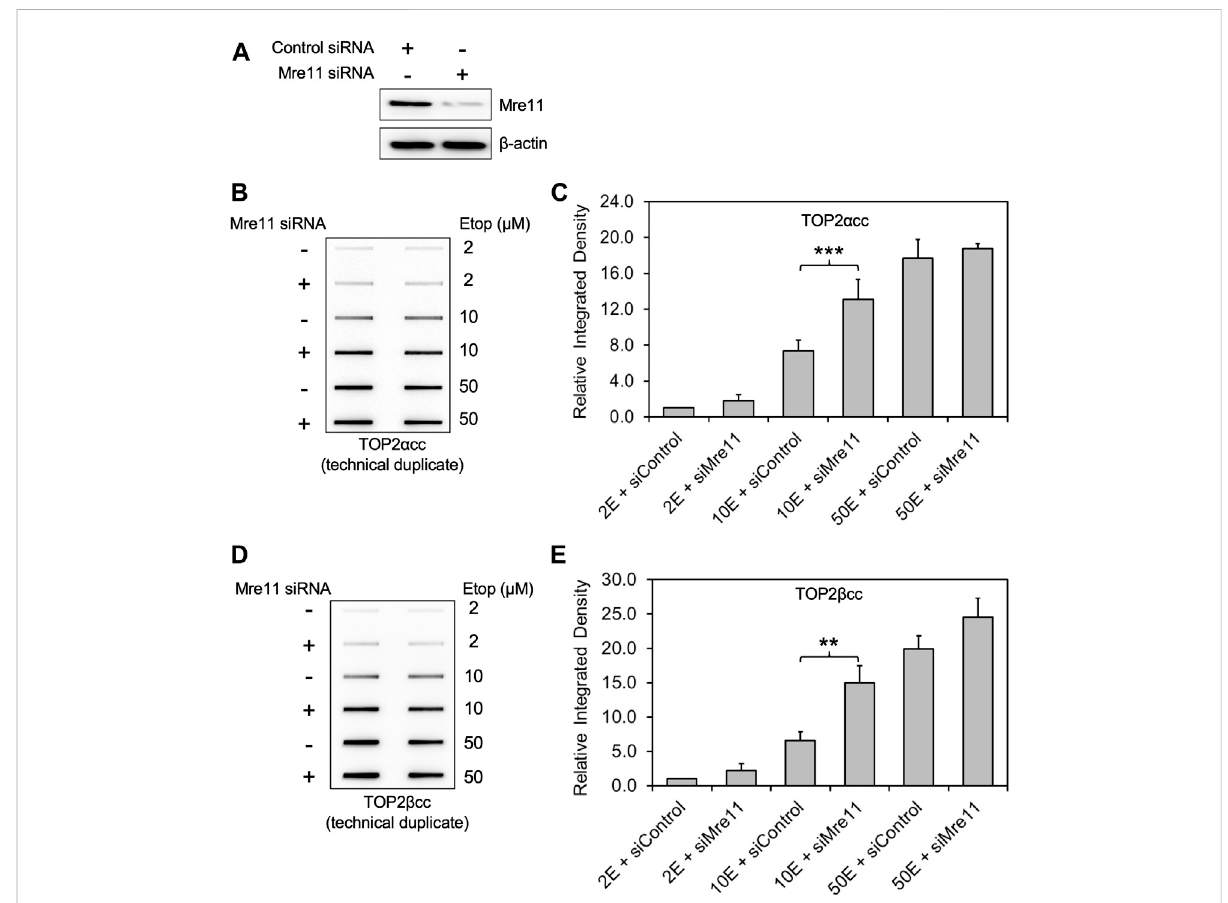
FIGURE 1 Knockdown of MRE11 by siRNA increases the level of etoposide-induced TOP2-DNA complexes as detected by ICE. RH30 cells were transfected with non-targeting siRNA control (siControl) or siRNA targeting MRE11 (siMRE11), followed by treatment with etoposide (Etop) at the indicated concentrations. (A) Western blot assessing MRE11 knockdown ef fi ciency. Semi-quantitative image analysis of immunoblots using ImageJ indicates that treatment with siMre11 resulted in 94% knockdown of endogenous MRE11 (quantitation not shown). (B) ICE assay illustrating TOP2 α cc in MRE11 knockdown cells. The panel illustrates a representative assay. In all cases, the assay includes technical replicates. At least three biological replicates wereperformedfor all experimentalconditions. Nodetectable signal isever observed underour conditions incells treatedwith a solvent control, over more than 20 experiments. Samples without etoposidewere therefore not typically analyzed in ICE assays. (C) Densitometric analysis of all experiments comparing relative integrated densities of TOP2 α cc signal amongst MRE11 knockdown and control cells treated with 2 μ M, 10 and 50 μ M etoposide (2E, 10E and 50E). Integrated density of TOP2 α cc signal of each group was normalized to that of control cells treated with 2 μ M etoposide. *** denotes p -value < 0.001, determined using Student ’ s t-test. Samples not marked with a bar did not result in a statistically signi fi cant difference. (D) ICE assay illustrating TOP2 β cc. The panel illustrates a representative assay. In all cases, the assay includes technical replicates. (E) Densitometric analysis of all experiments comparing relative integrated densities of TOP2 β cc signal amongst MRE11 knockdown